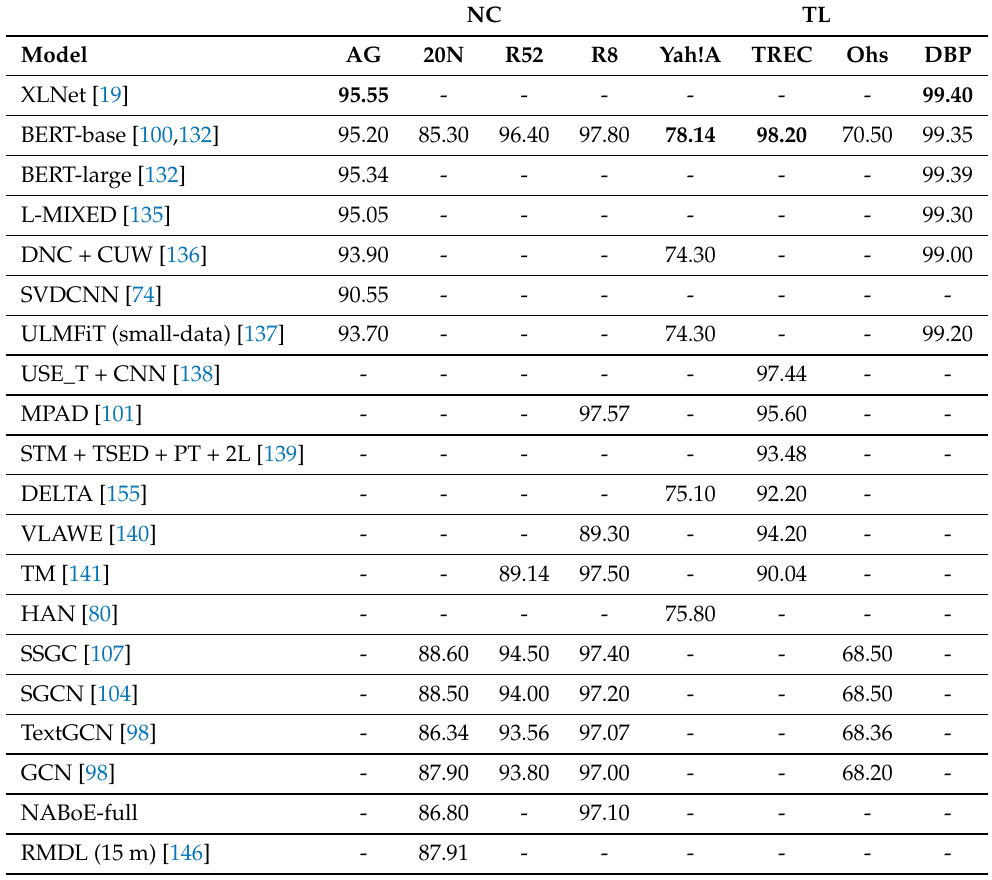
Table 5. Test accuracy score (%) on NC and TL benchmark datasets (best results in